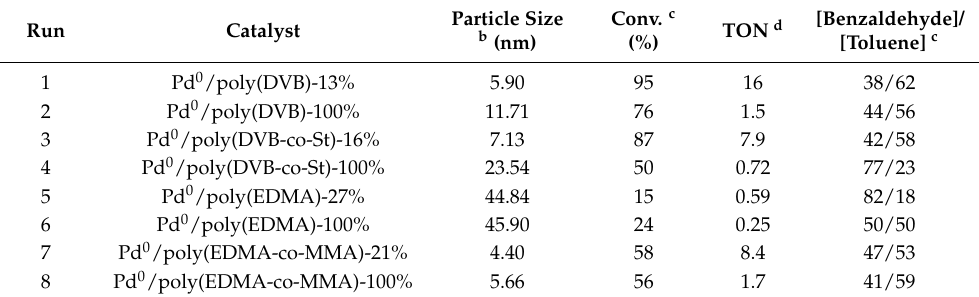
Table 3. Oxidation/disproportionation of benzyl alcohol by using Pd 0 /VPGs at 85 ◦ C for 1h a